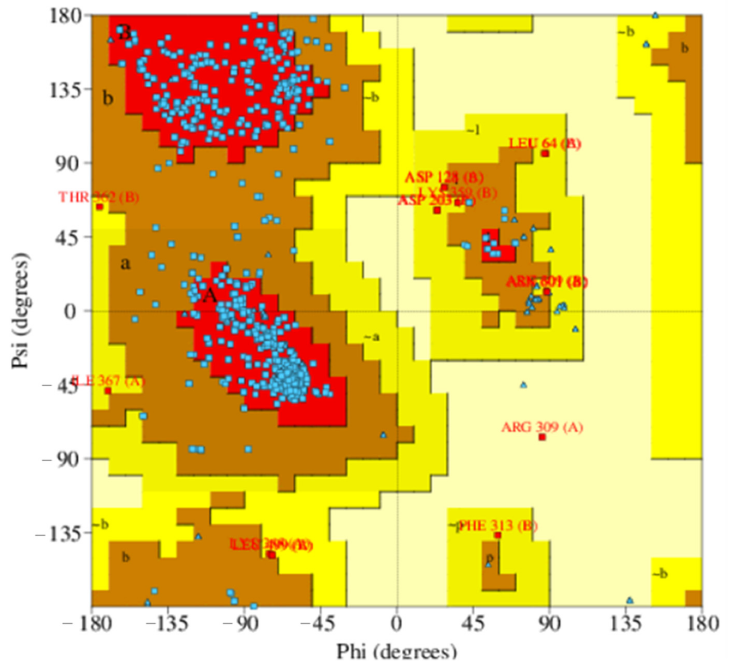
Figure 7. Ramachandran plot of the best ABCG2 homology model, in which the most favored regions, the additional allowed regions, the generously allowed regions and the disallowed regions were labeled [A, B, L]; [a, b, l, p]; [~a, ~b, ~l, ~p] and [XX], respectively. Using the Site Finder search tool and docking with Lead IT, the binding site of ABCG2 inhibitors was determined in Figure 8, which consisted of 20 amino acids belong-